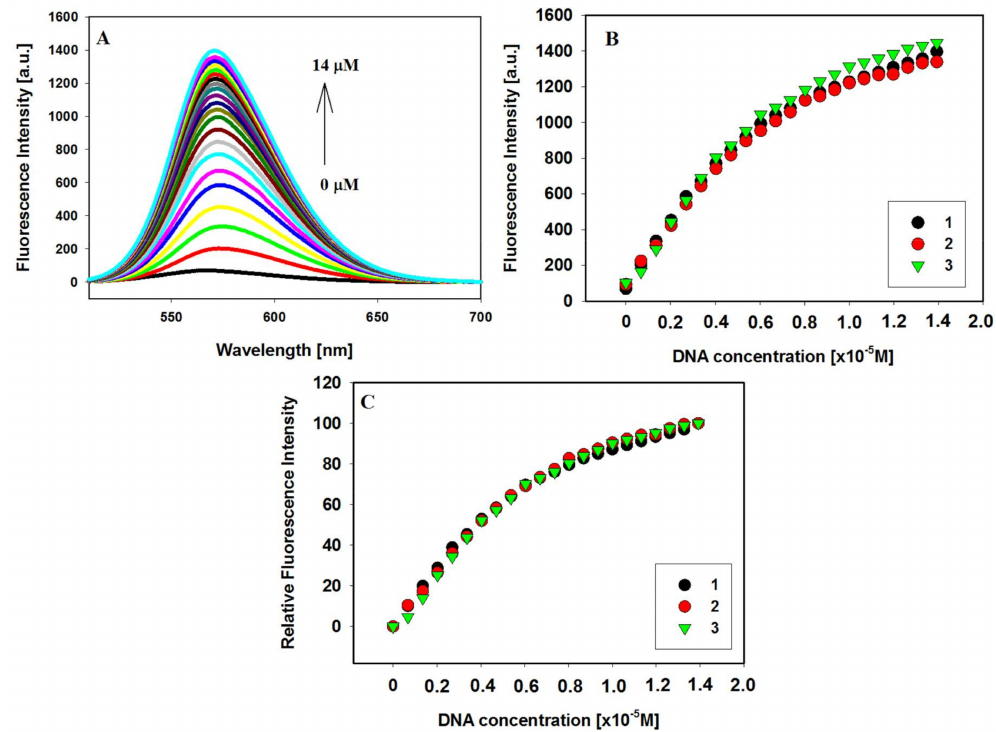
Figure 4. Fluorescence titration spectra of ligand 1 (2 µ M) with GQ c-KIT 1 (0–14 µ M) in Tris-HCl buffer (10 mM, pH 7.2) containing 100 mM KCl ( A ); Fluorescence binding curves ( B ) and relative enhancement in the fluorescence intensities ( C ) of ligands vs. the increasing concentration of G-quadruplexes c-KIT 1; λ ex : 1 , 3 —493 nm, 2 —492 nm. Table 2. Parameters for the interaction of ligands 1 , 2 and 3 with c-KIT 1 G-quadruplex determined using Benesi-Hildebrand method in absorption and fluorescence titration experiments (K b —binding constant, n —number of bound ligand molecules per